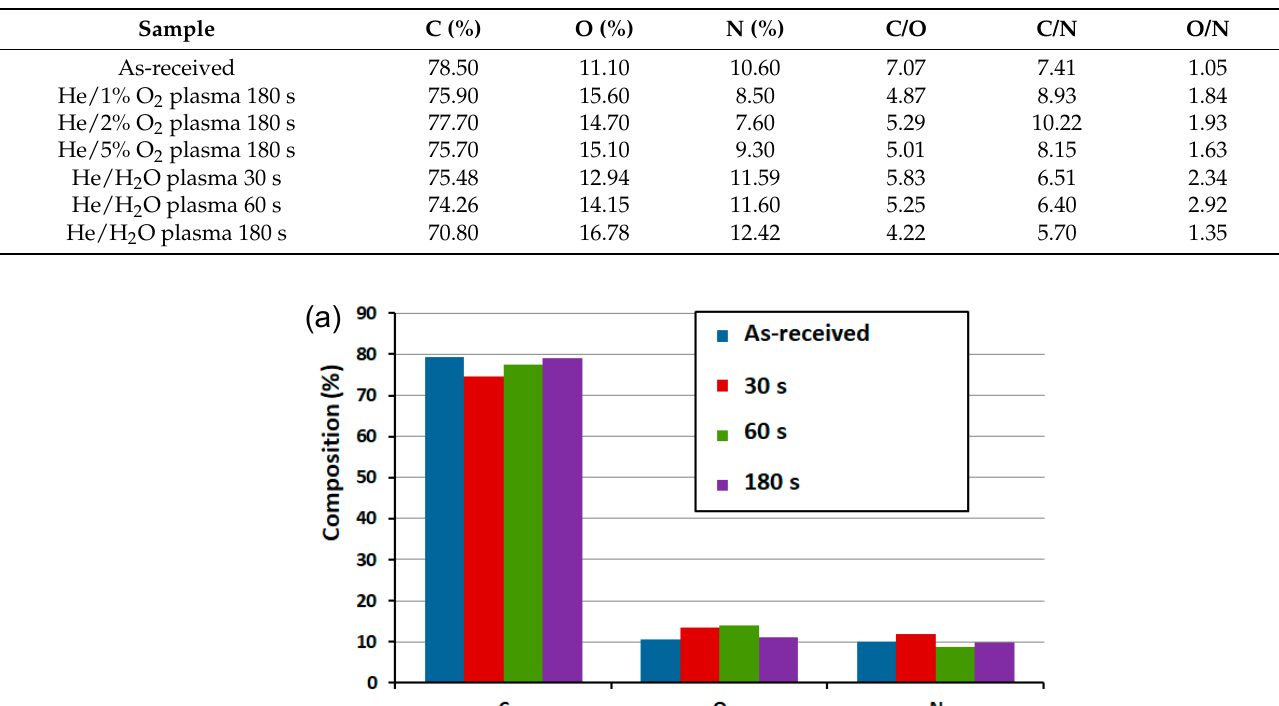
Figure 9. Surface composition represented by the atomic percentages of carbon (C), oxygen (O) and nitrogen (N) of the nylon surface after He/O 2 plasma treatment for 180 s. Table 1. Composition of as-received and plasma-treated nylon surfaces, as represented by the atomic percentages of carbon (C), oxygen (O) and nitrogen (N); and their relative ratios including C/O, C/N and O/N.